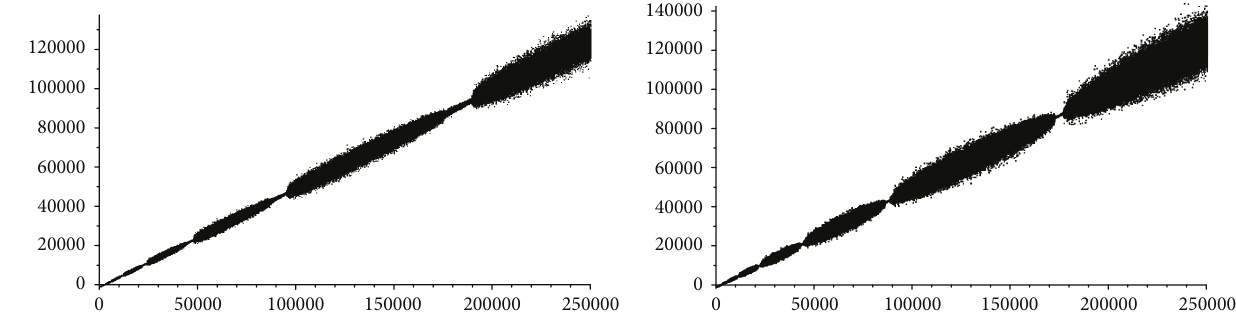
Figure 1: Scatterplots of Hofstadter ’ s Q -sequence and Q